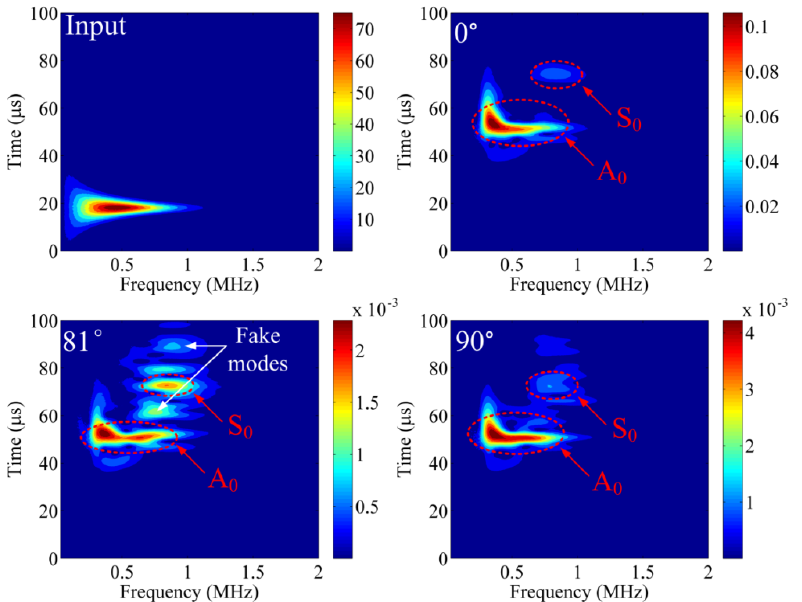
Figure 9. CWT results for input